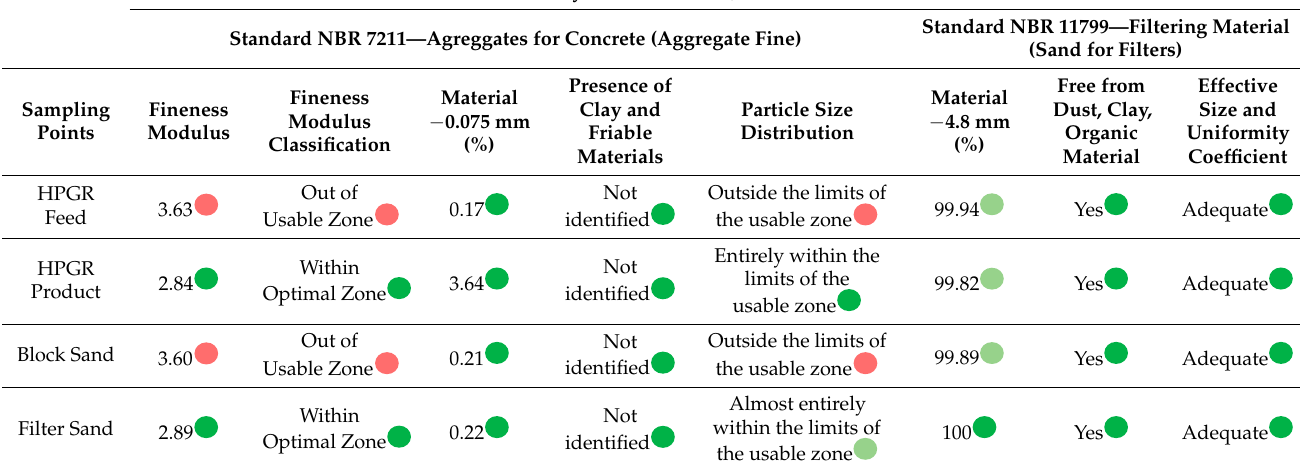
Table 8. Survey 1 product analysis.